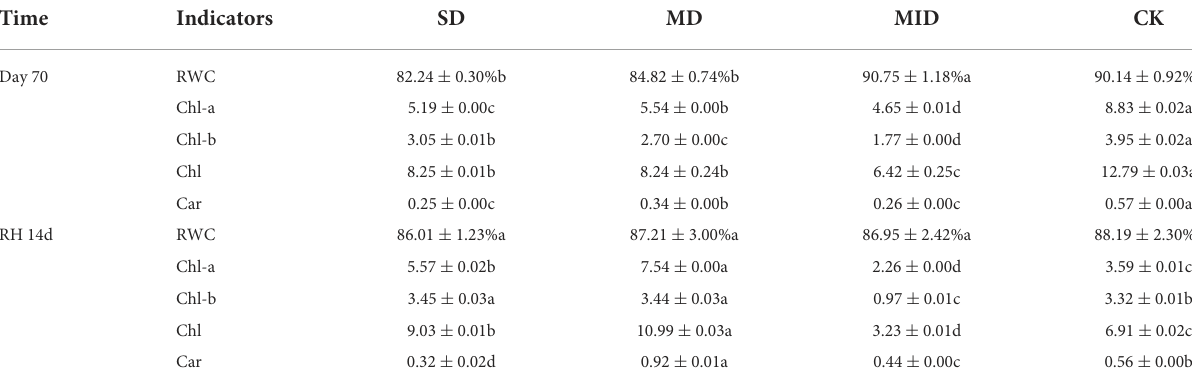
TABLE 2 RWC and photosynthetic pigment content of A. selengensis leaves after drought (Day 70) and rehydration (RH, 14 d). Time Indicators SD MD MID CK Day 70